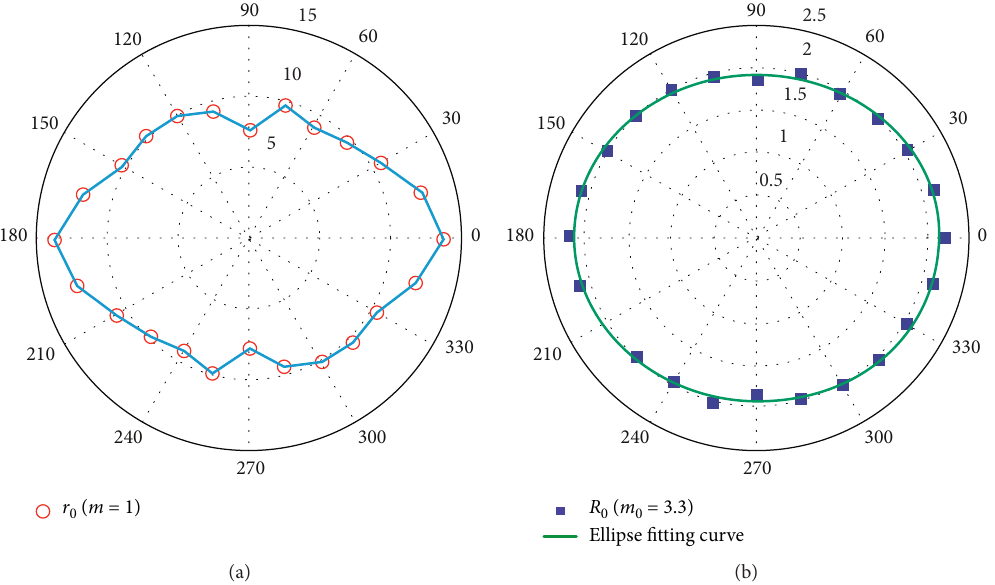
Figure 5: Polar plots of the original and processed JRC values and the ellipse fitting curves of the test samples in the length of